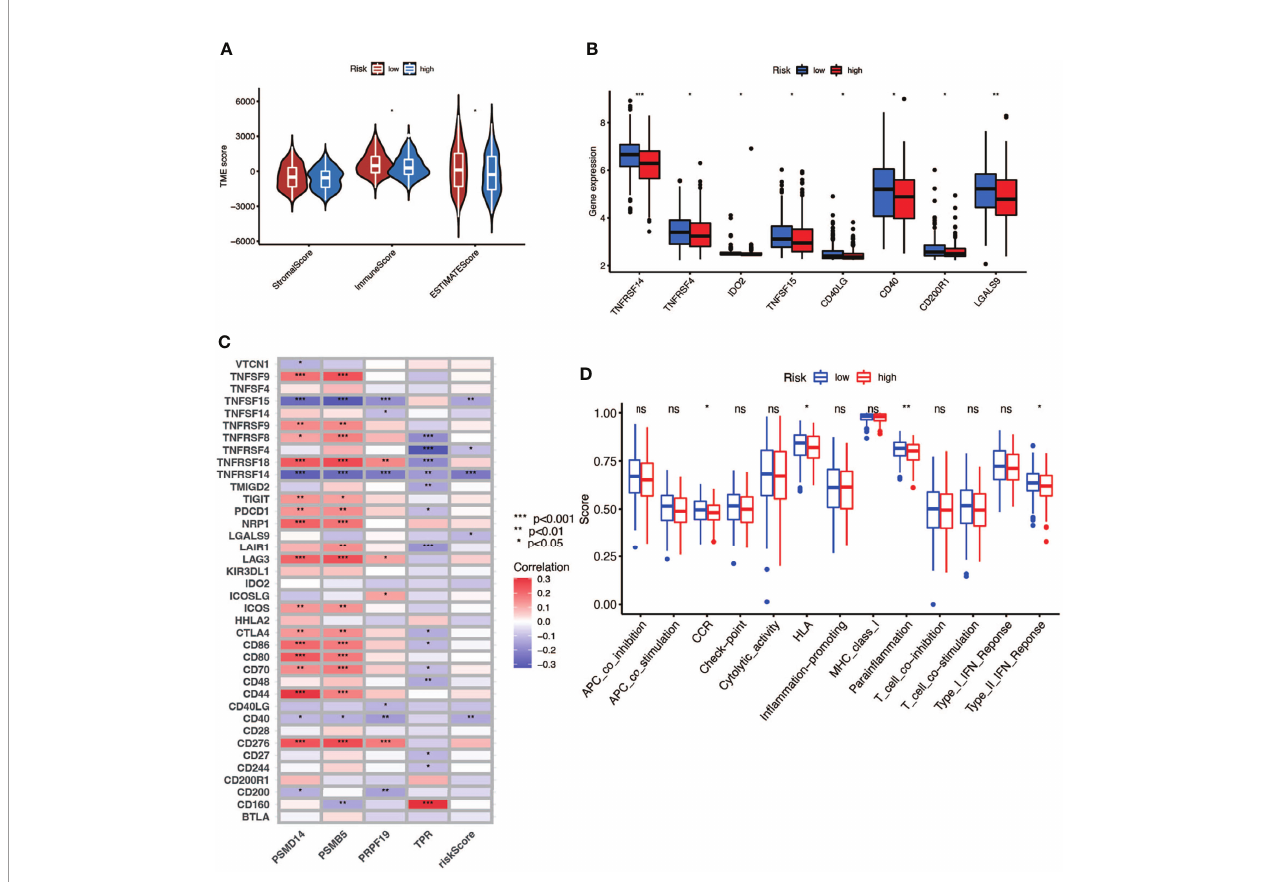
FIGURE 6 | The relationship between risk score and TME. (A) TME scores of high- and low-risk patients (* P < 0.05; ** P < 0.01; *** P < 0.001). (B) Immune checkpoints expression in high- and low-risk-score patients (* P < 0.05; ** P < 0.01; *** P < 0.001). (C) Correlation between immune checkpoints and four genes (* P < 0.05; ** P < 0.01; *** P < 0.001). (D) Comparison of immune-related function of high- and low-risk-score patients (ns, no signi fi cance; * P < 0.05; ** P < 0.01; *** P <